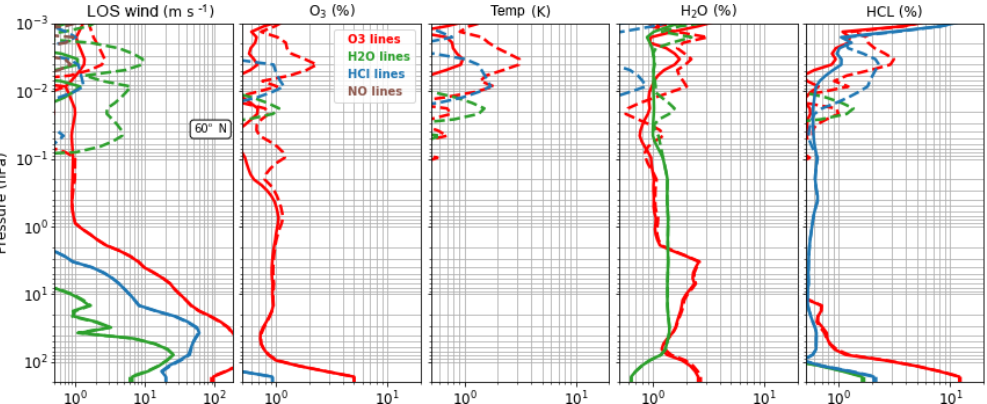
Figure 10. Spectroscopic-induced errors in LOS wind, temperature, O 3 , H 2 O and HCl retrievals (see panel titles). The full lines (dashed lines) show the nighttime (daytime) conditions at 60 ◦ N.